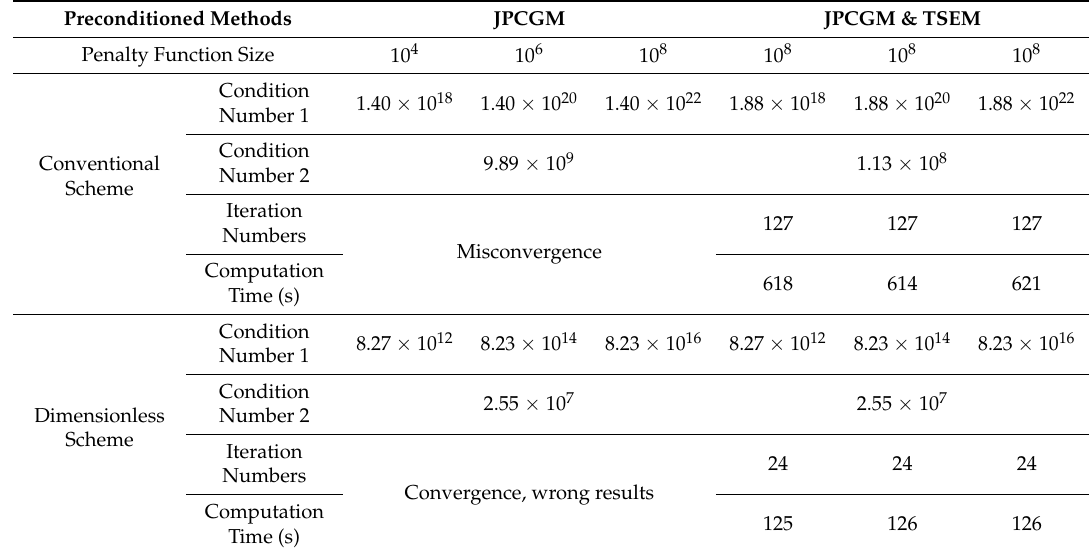
Table 4. Convergence of discrete equations with different schemes and penalty